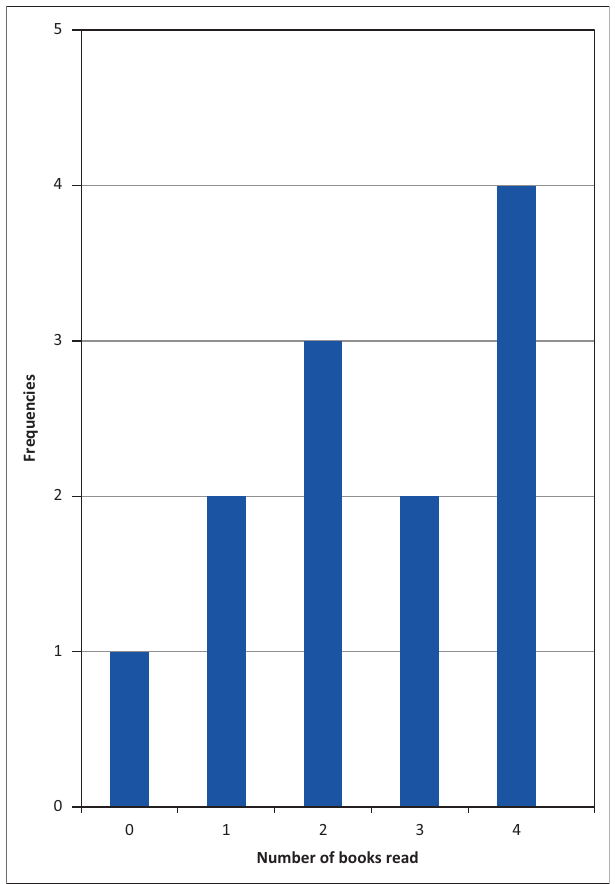
FIGURE 4: Distribution bar graph for the number of books read by 12